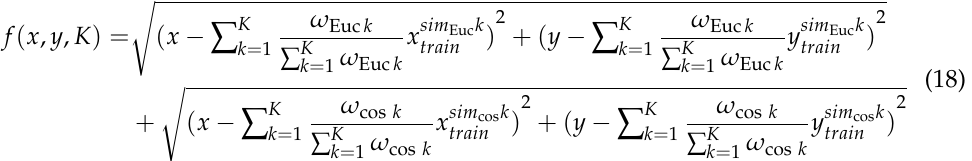
Algorithm 1 The algorithm procedure of